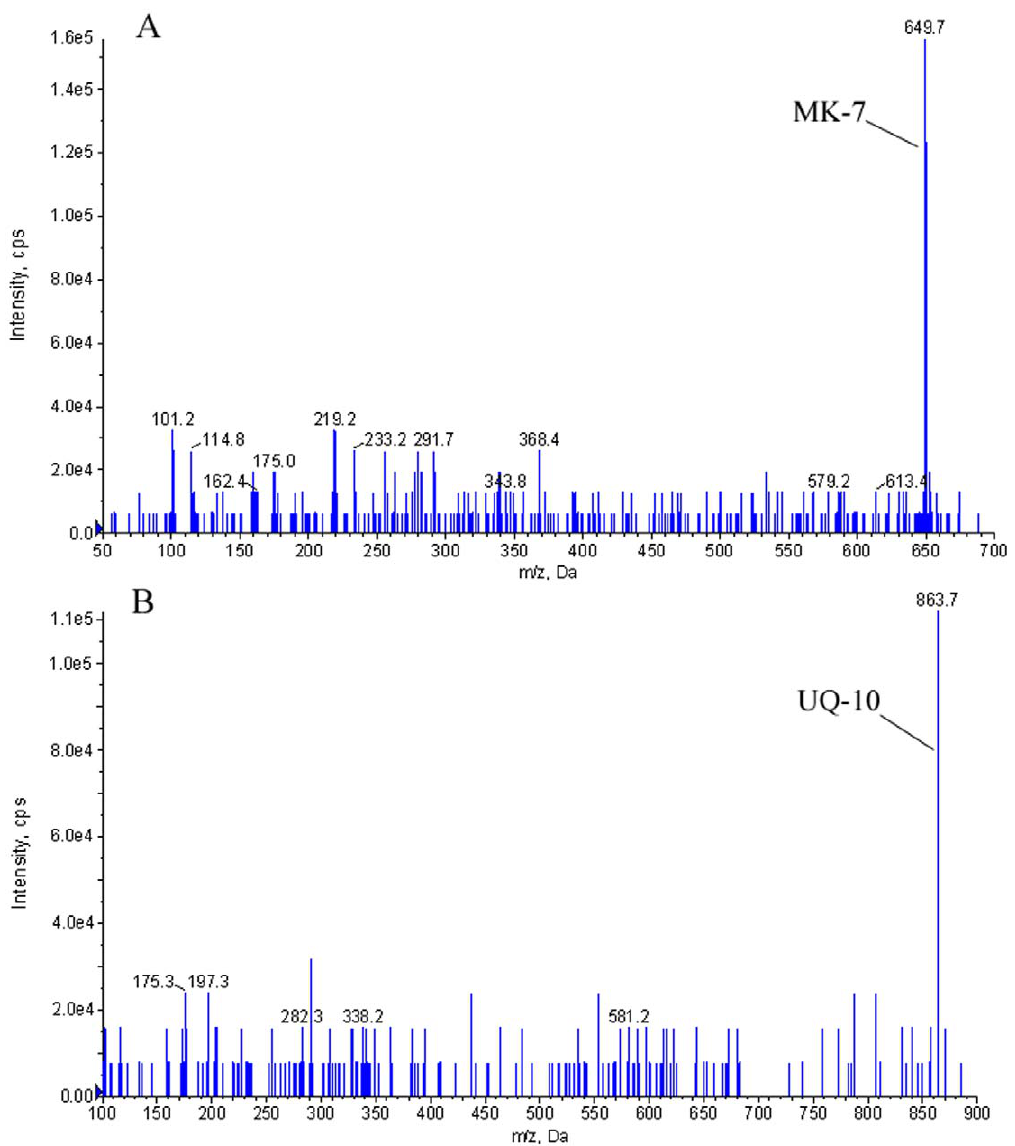
Figure 6. Mass spectrum of quinine compounds from M.huakuii 7653R cultured under microaerobic condition. (A) The mass spectrum of MK7 which showed that MK7 was accumulated in M. huakuii 7653R under microaerobic respiration. (B) The mass spectrum of UQ-10 which showed that UQ-10 was accumulated in M. huakuii 7653R.